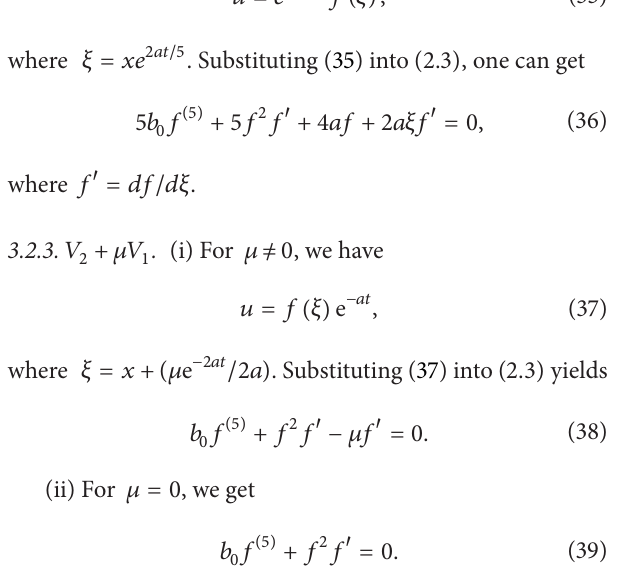
Table 7: Commutator table of the Lie algebra of (3.3).